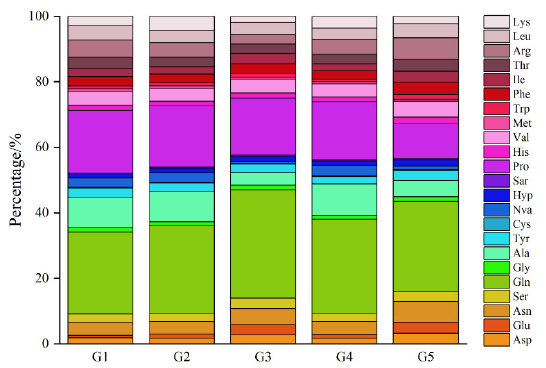
Figure 2. Stacking chart of FAAs in pickled BLS with different salt concentrations.